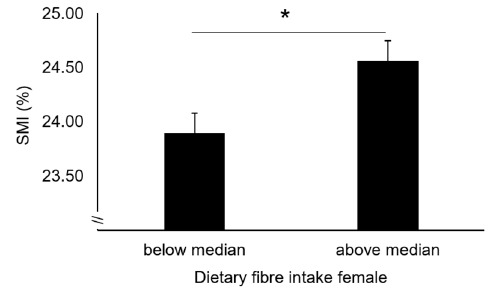
Figure 1. Skeletal muscle mass in older women below and above median FI. Data are estimated marginal means ± SEM adjusted for age, recruiting centre, total energy intake and prevalence of metabolic syndrome. SMI, Skeletal Muscle Mass Index. * p < 0.05.